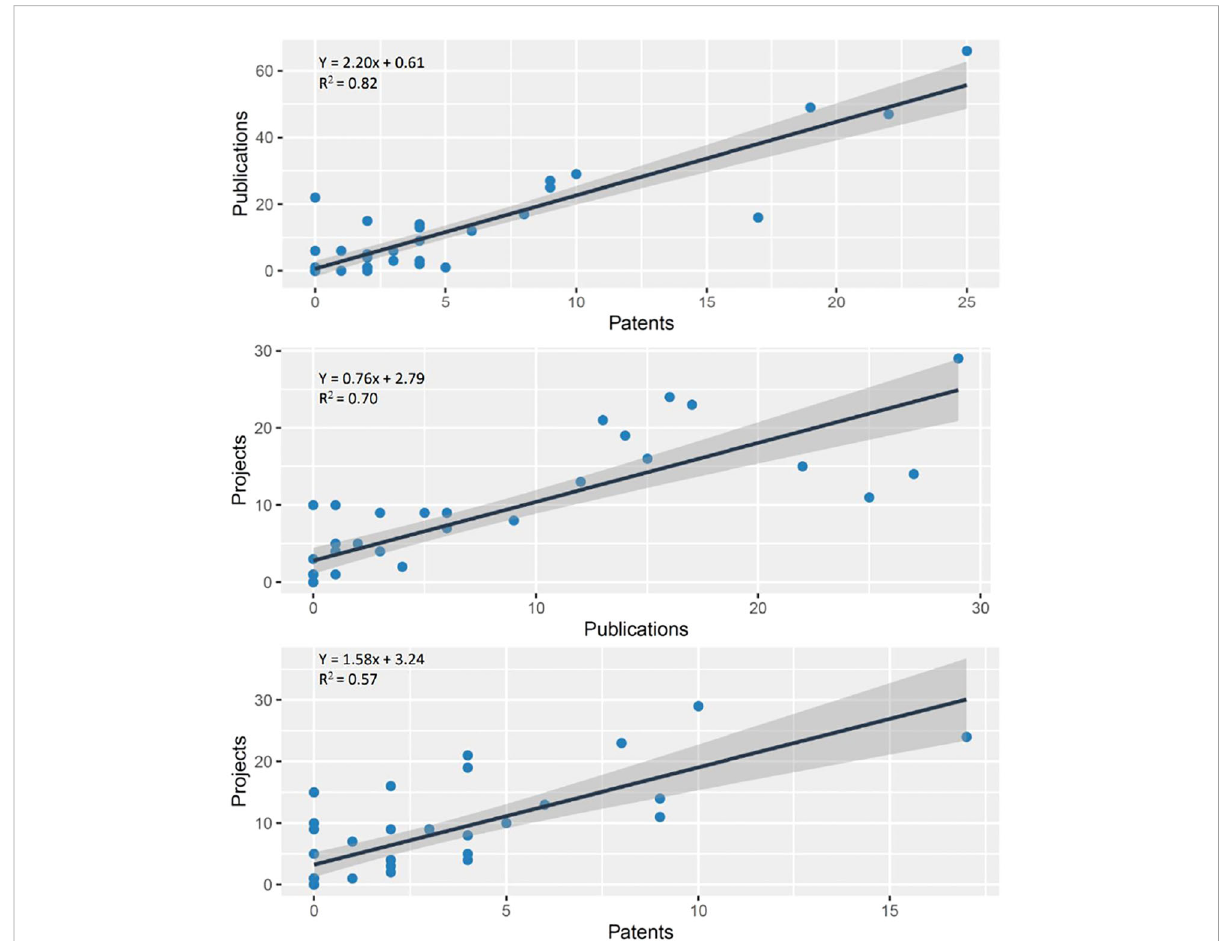
FIGURE 2 Scatterplots exploring the relationship between research effort (i.e., publications), active restoration projects, and technological innovation (i.e., patent output). The grey bands represent the standard error of the regression